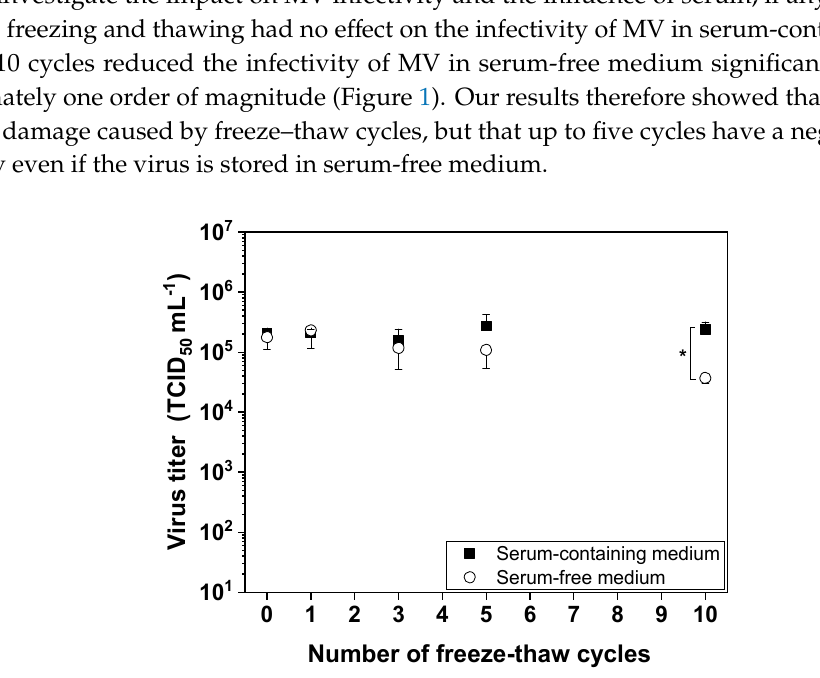
Figure 1. Influence of repeated freeze–thaw cycles on measles virus (MV) infectivity. MV aliquots were frozen at –80 °C for at least 2 h and thawed for 15 min in a water bath at room temperature, representing one cycle. Up to 10 freeze–thaw cycles were performed. Data are means plus standard deviations ( n = 3; * p < 0.05).